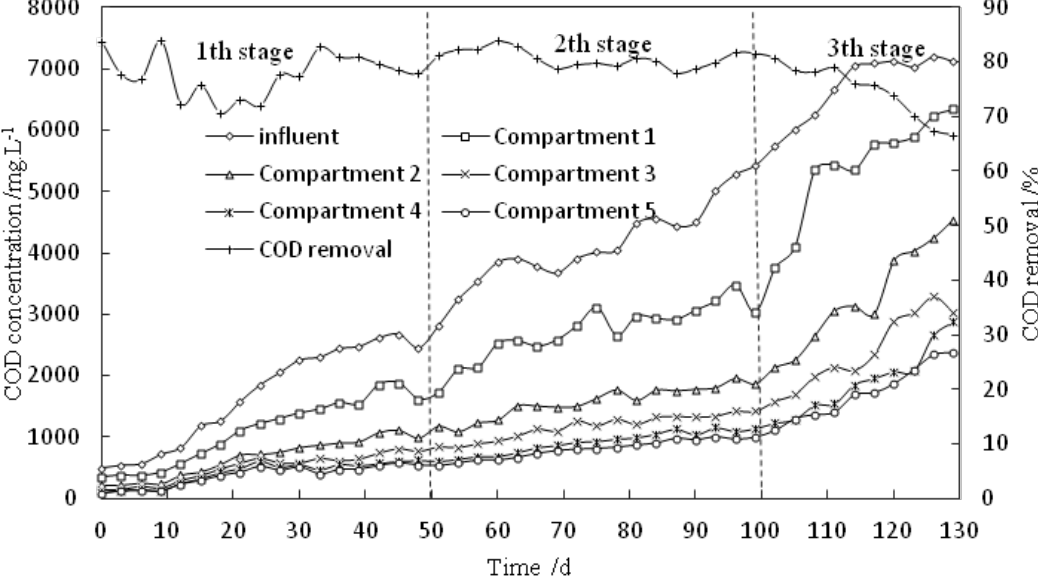
Figure 2. Chemical oxygen demand (COD) removal contributed by each compartment of the reactor